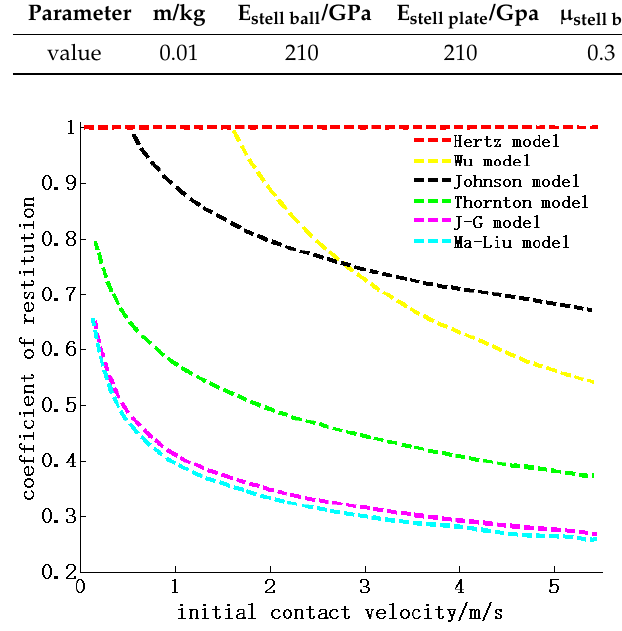
Figure 2. Comparison of the coefficient of restitution models.